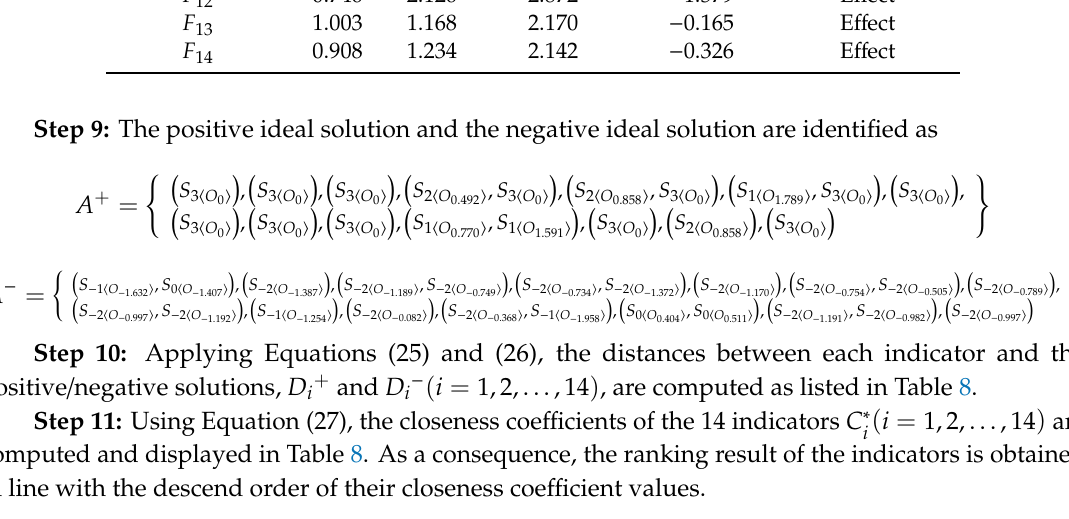
Table 8. Computation results by the TOPSIS